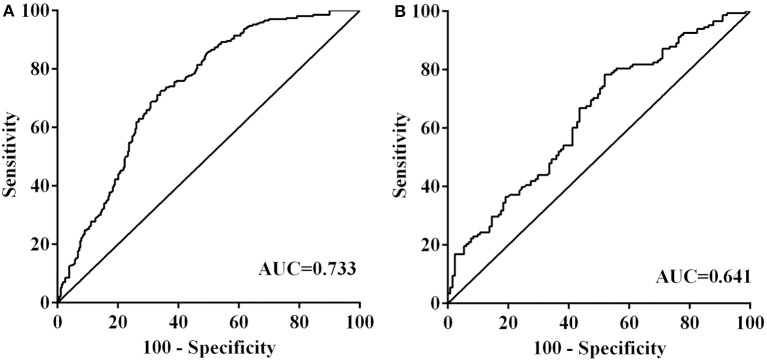
Receiver operator characteristic analysis of neutrophil-to-platelet ratio for predicting hemorrhagic transformation (A) and parenchymal hematoma (B). AUC, area under the curve.